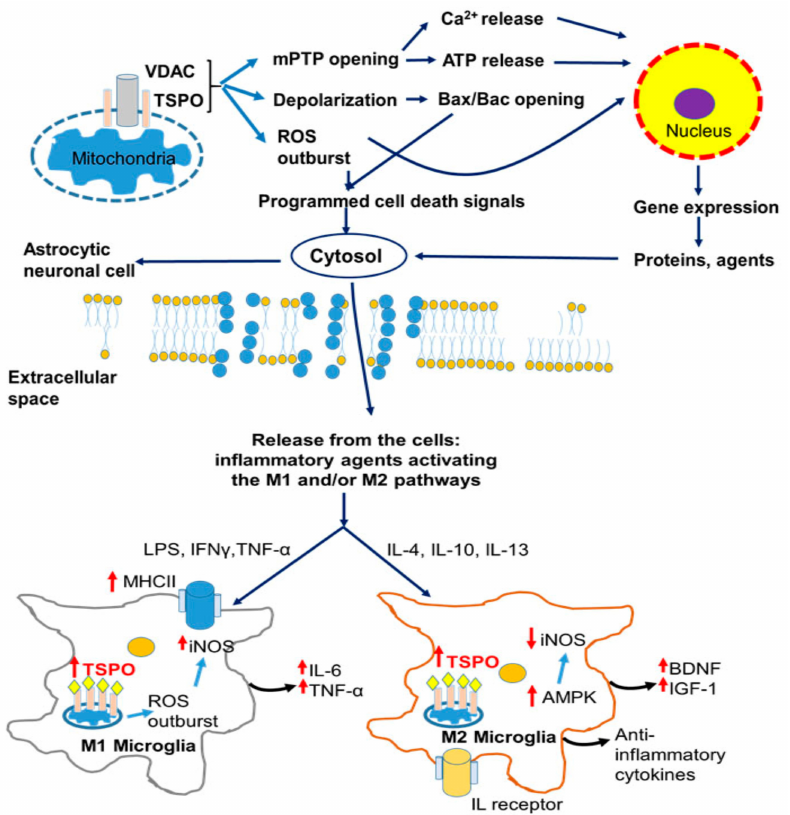
Figure 4. Intracellular manifestation of TBI in neurons and astrocytes, resulting in microglial activation. AviciouscycleofcelldeathandactivationassociatedwithenhancedTSPOresponses’expressioninbrain injury is reflected by cellular apoptosis and necrosis attained by way of mPTP opening and a decrease of intraneuronal ATP, which consequently triggers the neuroinflammatory response by microglial activation. Proinflammatory (M1) microglial phenotype activated by LPS, TNF- α , or IFN γ stimulation, and characterized by the expression of iNOS, MHCII, and significantly increased TSPO BP, contribute to ROS overproduction and the secretion of injury-mediated cytokines. The anti-inflammatory (M2) microglial phenotype is stimulated by interleukins (IL-4, IL-10, IL-13) and characterized by the secretion of BDNF, IGF-1, and anti-inflammatory cytokines. On the one hand, based on our various studies, we arrive a the assumption that mitochondrial membrane depolarization leads to programmed cell death; on the other hand, less pronounced e ff ects on the mitochondrial membrane potential, but still allowing for ROS generation, and Ca 2 + and ATP release into the cytosol, will lead to gene expression modulation that is part of: Microglial activation, astrocytic activation, neuronal and astrocytic cell death,